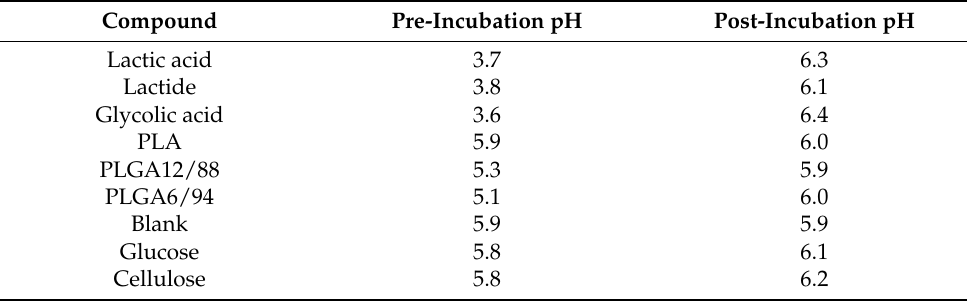
Table A2. pH of soil mixture (0.01 M CaCl 2 ) before and after